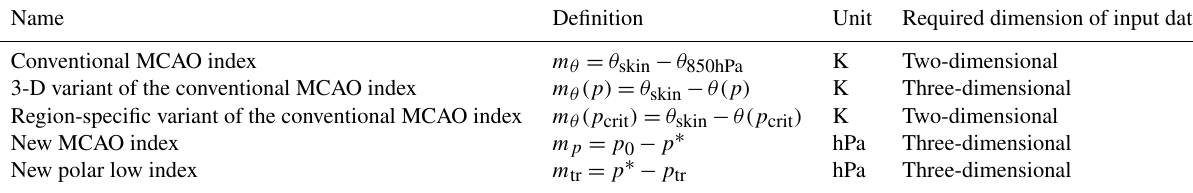
Table 1. Diagnostic indices for measuring MCAOs. The term “conventional MCAO index” summarizes previously used diagnostics that are based on the difference in potential temperature between the ocean surface and a fixed characteristic pressure level aloft, such as, e.g., 850hPa (Papritz et al., 2015; Kolstad, 2017; Polkova et al., 2021), or other levels (Kolstad et al., 2009; Fletcher et al., 2016; Papritz and Sodemann, 2018; Landgren et al., 2019). Notation: θ skin , θ 850hPa , θ(p) , and θ(p crit ) denote the potential air temperature at the surface; at 850hPa; at pressure level, p ; and at a critical characteristic pressure level, p crit (see Sect. 3.3.4), respectively. p 0 , p ∗ , and p tr denote the air pressure at the surface, at the upper boundary of MCAOs, and at the dynamical tropopause, respectively. Details of the indices are given in the text (see Eqs. 1, 2, and 7 for the conventional MCAO index, its 3-D variant, and a region-specific variant obtained by fitting to data about observed PLs; see Eqs. 3 and 4, for the new MCAO and polar low indices,